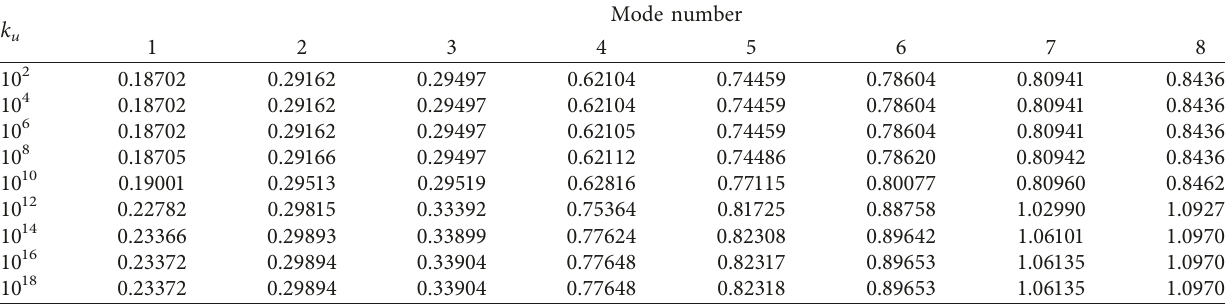
Table 2: Comparison of the frequency parameters Ω of an orthotropic plate elastically restrained in the x direction.